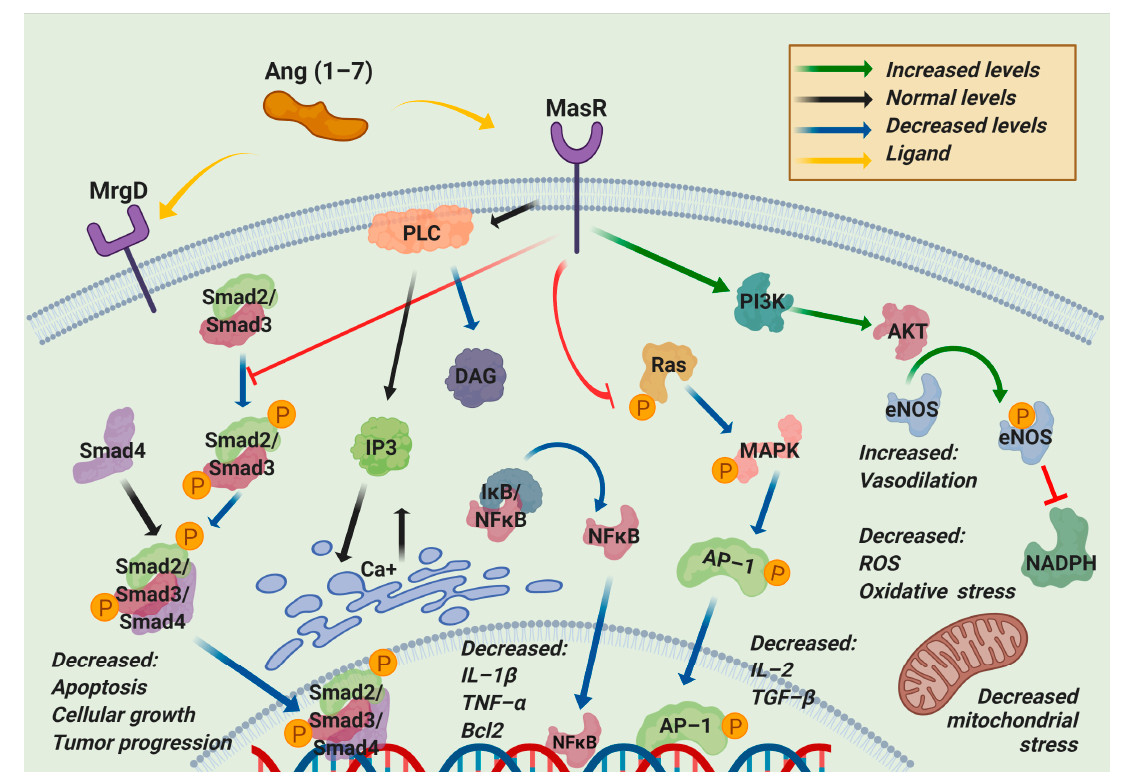
Figure 4. Regulated pathways of the nonclassical RAS axis. Angiotensin (1–7) (Ang (1–7)) can bind to Mas-related G-protein coupled receptor type D (MrgD) or Mas receptor (MasR). This interaction blocks the phosphorylation of the components of the two main pathways, Ras/Mitogen-activated protein kinase (MAPK) and Smad, resulting in the downregulation of apoptosis, cellular growth, tumor progression, inflammation, oxidative stress, reactive oxygen species, and mitochondrial stress. On the other hand, this interaction upregulates phosphatidylinositol-3-kinase (PI3K) to increase endothelial nitric oxide synthase (eNOS) phosphorylation, blocking the nicotinamide adenine dinucleotide phosphate reduced (NADPH) activity, decreasing the oxidative stress, and increasing the vasodilation. PLC: Phospholipase C; DAG: diacylglycerol; IP3: Inositol trisphosphate; IkB: inhibitor of nuclear factor kappa; NF K B: nuclear factor kappa-light-chain-enhancer of activated B cells; IL-1 β : interleukin 1 beta; TNF- α : Tumor necrosis factor alpha; Bcl2: B-cell lymphoma 2; Ras: Rat sarcoma virus; AP-1: activator protein 1; AKT1: AKT serine/threonine kinase 1; ROS: reactive oxygen species.